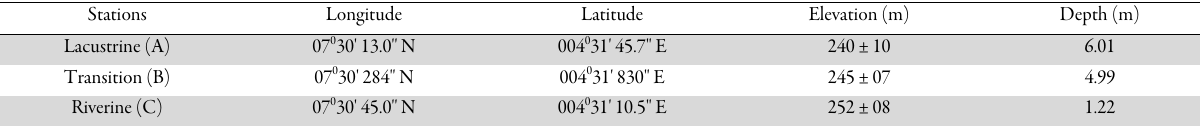
Table 1. Grid location of selected sampling